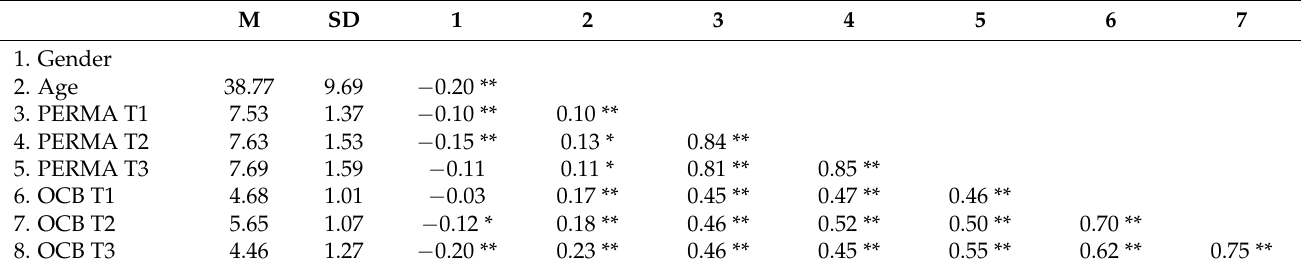
Table 4. Descriptive and inter-correlations for Model 3